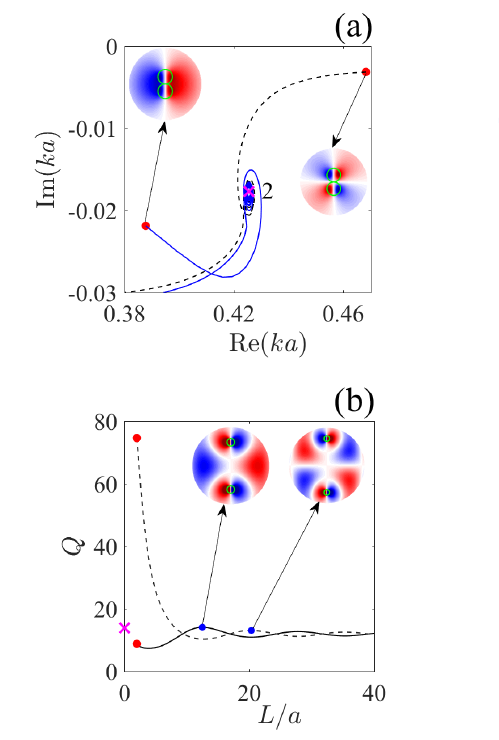
Figure 6: The same as in Fig. 5 for the dipole resonant modes ψ s ; s/a symmetric relative to x → − x . Cross marks the Mie resonance (a) and respectively Q factor of the iso- lated cylinder (b).